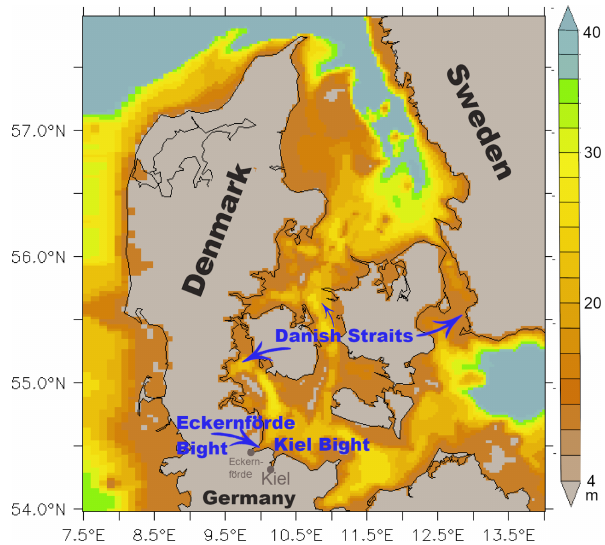
Figure 1. Overview map. The colors indicate water depth (in